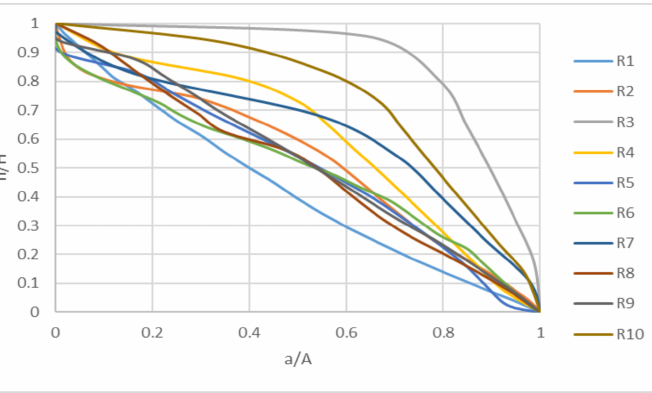
Figure 7. Hypsometric curves for ten reservoirs created using the A-h and V-h relationship